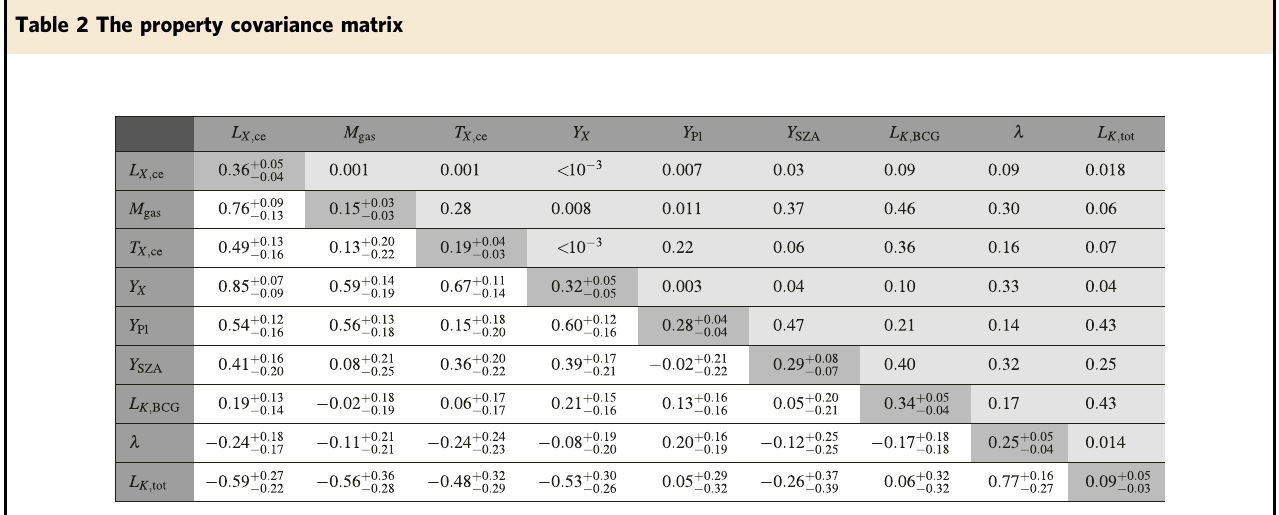
Lower triangle (white colored cells): Posterior median and 68th percentile range of property pair correlation coef fi cients at fi xed weak-lensing mass. Upper triangle (light gray colored cells): Statistical signi fi cance ( p -value) of the sign of the estimated property correlation, calculated as the cumulative posterior probability of having positive (negative) correlation values if the median is negative (positive). Diagonal (gray colored cells): Posterior median and 68th percentile range of the intrinsic scatter of each property at fi xed weak-lensing mass